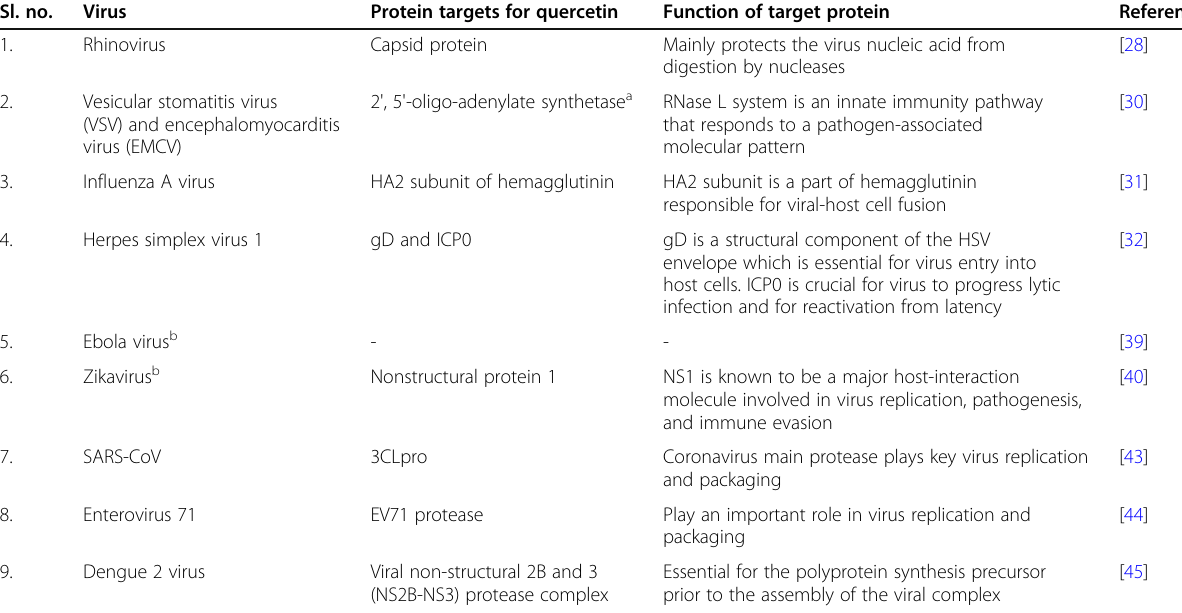
Table 1 Target proteins for quercetin in human viruses and their functions Sl.